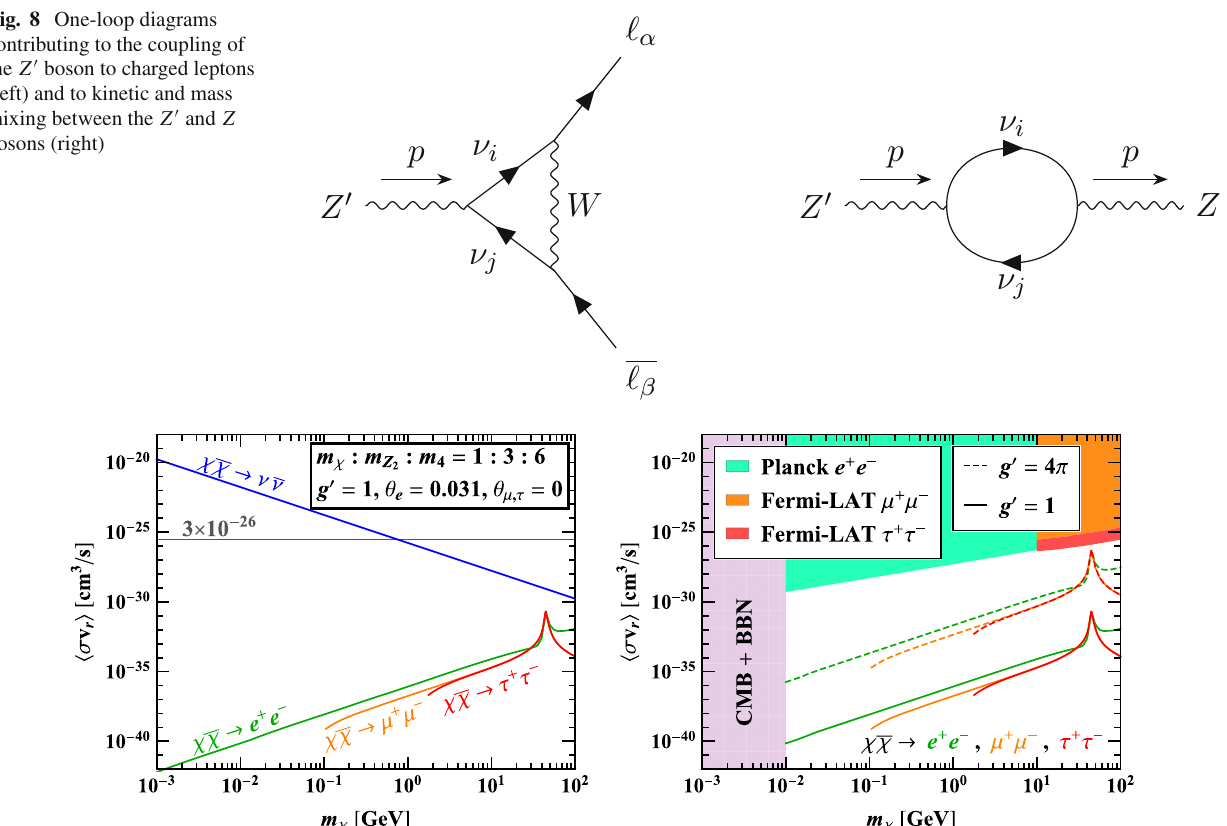
Fig. 8 One-loop diagrams contributing to the coupling of the Z (cid:9) boson to charged leptons (left) and to kinetic and mass mixing between the Z (cid:9) and Z